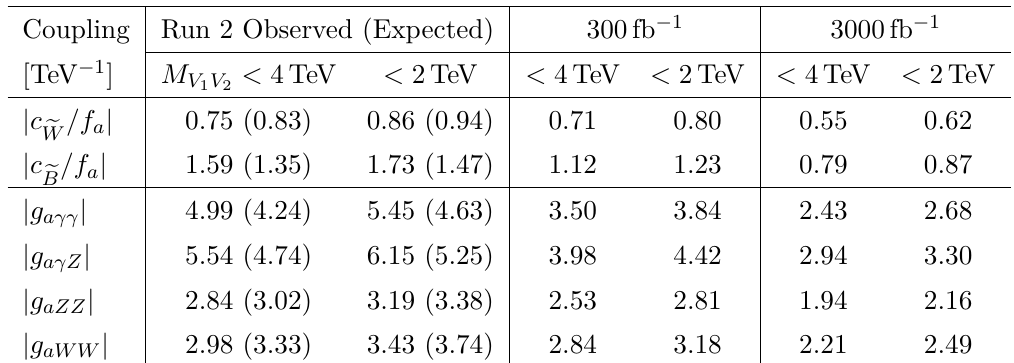
Table 5 . 95% CL upper limits on the absolute value of the Wilson coefficients c projected onto the ALP couplings to physical bosons, eq. (2.2). The various columns report current bounds extracted from CMS Run 2 measurements and projected sensitivities for LHC higher luminosities, for signal events with M V 95% CL allowed region onto different directions in the ( c